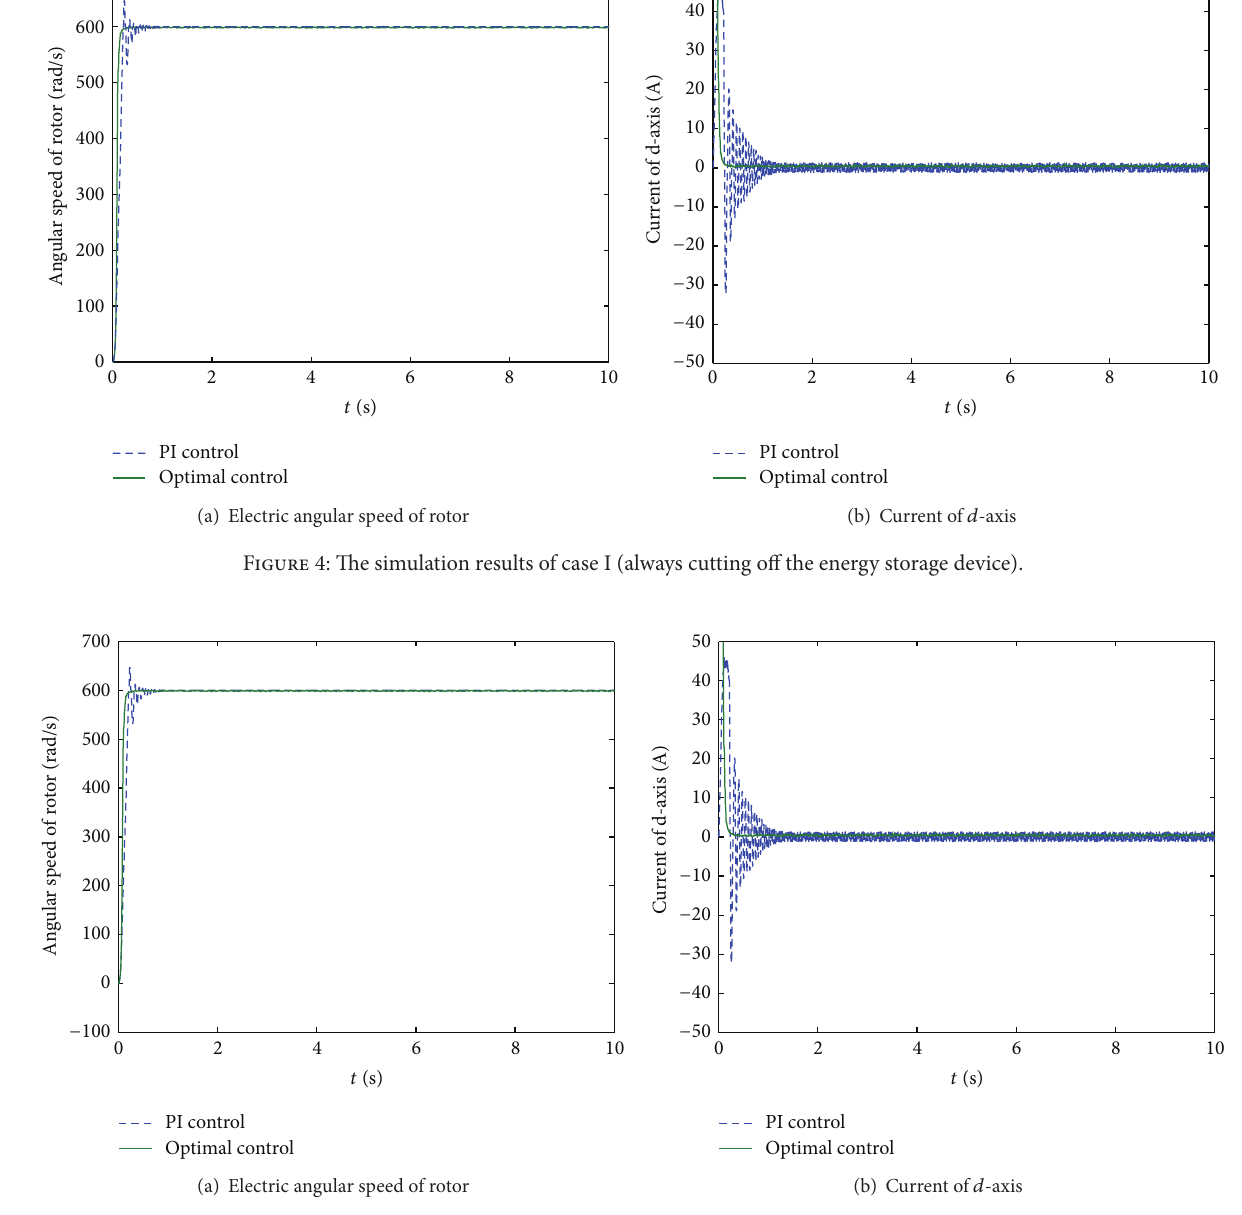
Figure 5: The simulation results of case II (from the initial state of storing no energy to the final state of storing full of